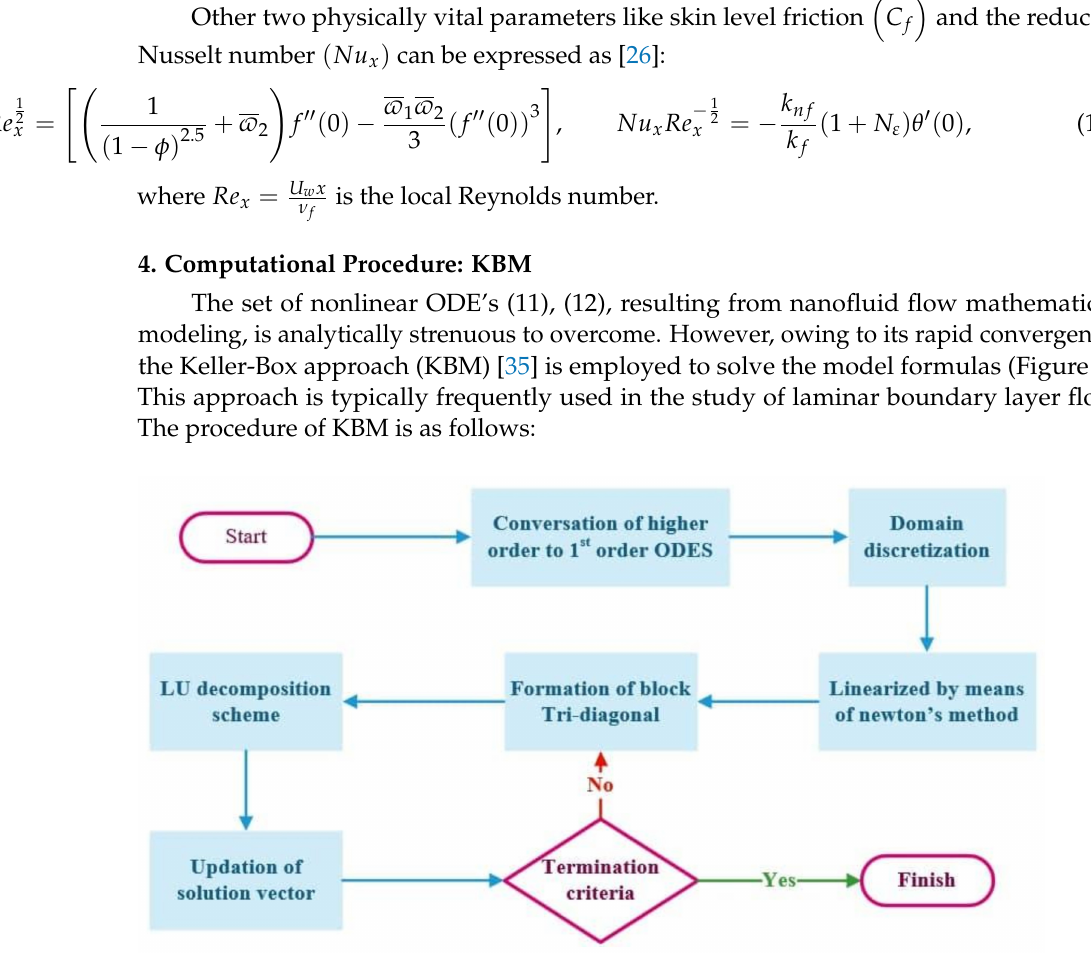
Figure 2. Chart of KBM